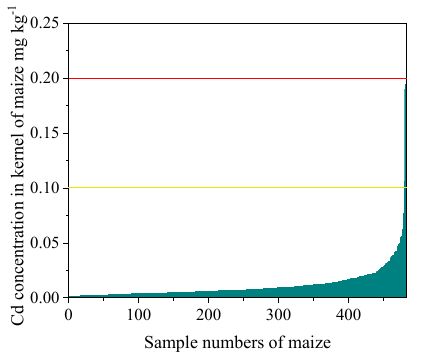
Figure 3. The relationship between the Cd concentration in maize kernels and sample numbers of maize. The yellow line represents the limit of light Cd contamination in maize kernels (0.1 mg kg − 1 ) as recommended by national standards. The red line represents the limit of heavy Cd contamination in maize kernels (0.2 mg kg − 1 ) as recommended by national standards.